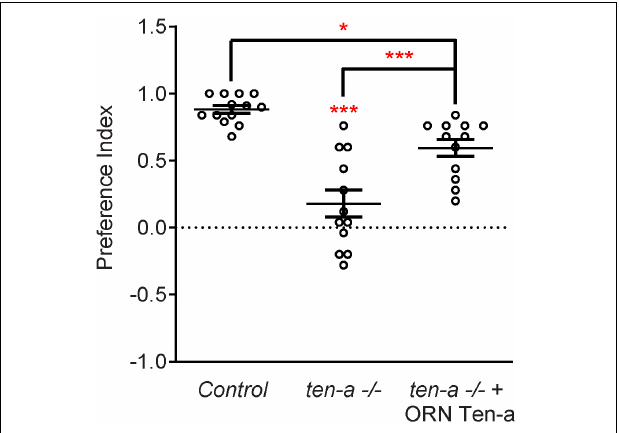
apple cider vinegar (ACV) (an attractive odorant) and water (a null solution). Control flies exhibit strong attraction to ACV while loss of ten-a nearly completely abrogates this attraction. This phenotype can be partially rescued by restoring Ten-a expression in ORNs of the ten-a mutant,